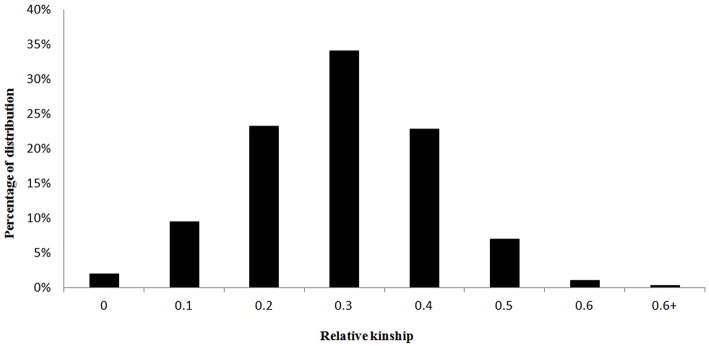
The distributions of pair-wise kinship coefficients for 138 M. sinensis individuals.